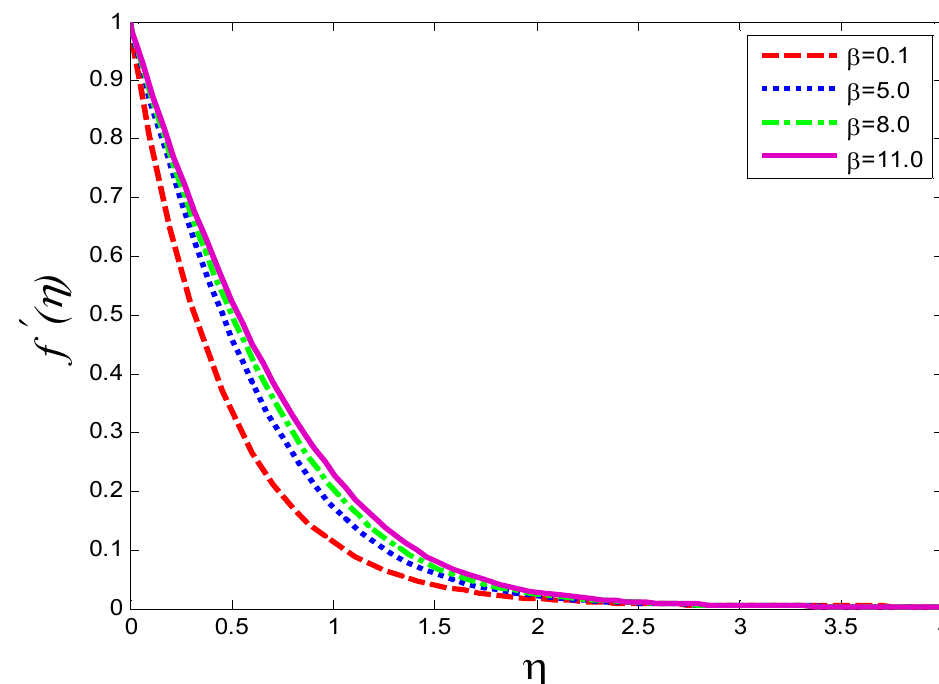
Figure 5. Effect of 𝐾 on 𝜙 .